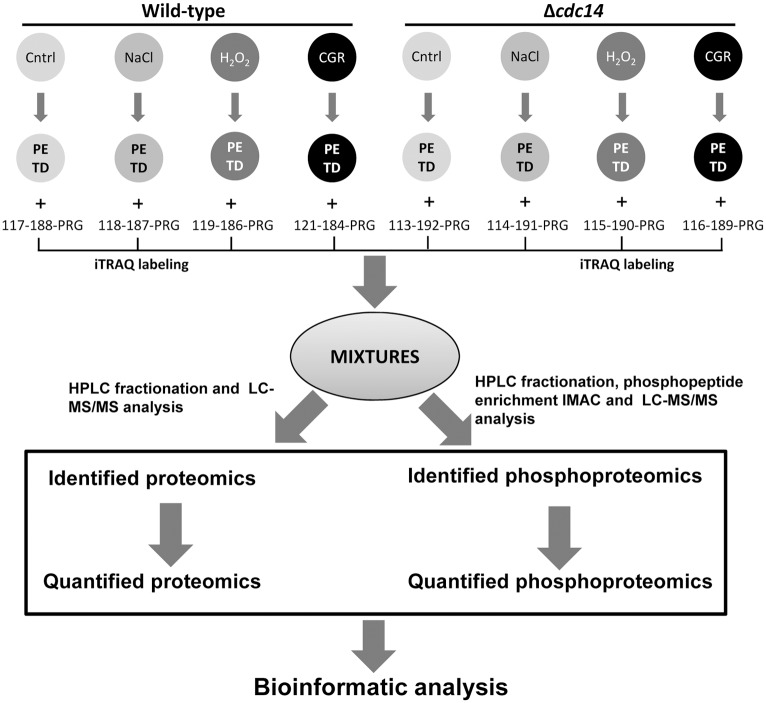
An experimental workflow for generating B. bassiana Cdc14-specific proteome and phosphoproteome.